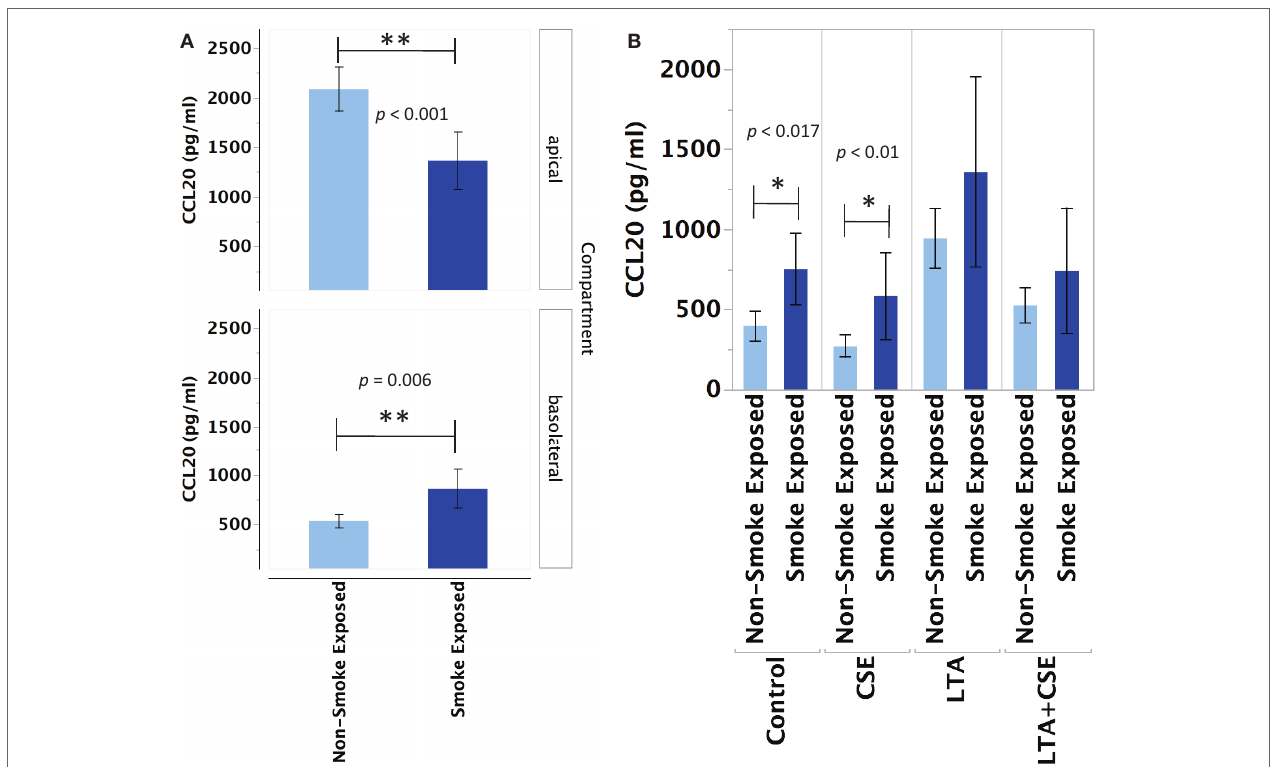
FigUre 2 | ccl20 secretion is altered in Phnec from in vivo smoke-exposed individuals. Compared to non-smoke-exposed individuals, smoke-exposed individuals had significantly lower apical CCL20 secretion and significantly higher basolateral CCL20 secretion (a) . Figure 2A shows secretion data pooled (from all treatments) from every PHNEC secretion sample. CCL20 secretion into the basolateral compartment is significantly higher in PHNEC from in vivo smoke-exposed individuals in the control (constitutive) and the CSE-exposed treatments (B)